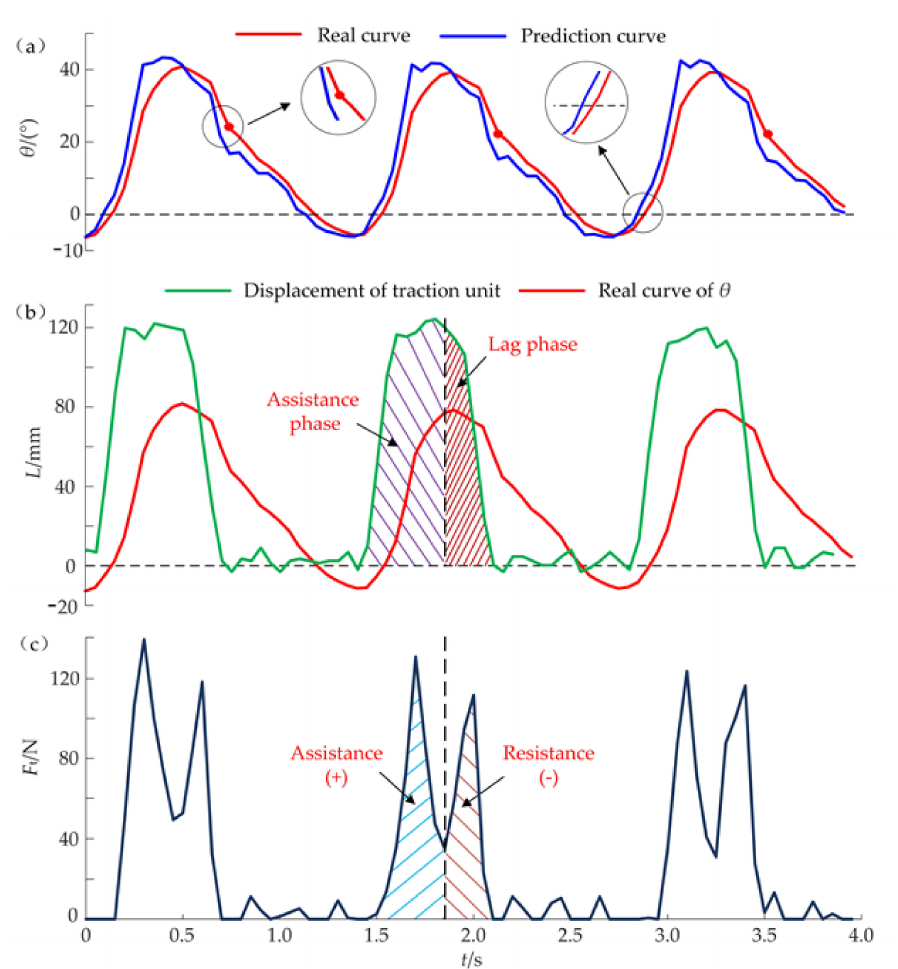
Figure 8. Dynamic data during the assistance process ( v 1 = 0.75 m/s, L c = 17 mm, ∆ t = 300 ms). ( a ) The prediction curve of the hip angle θ has a similar shape and advances a time interval compared with the real curve. ( b ) The output displacement L is determined by the parameters L c and ∆ t . ( c ) The auxiliary forces F t hinder the extension movements at the later stage due to the improper values of L c and ∆ t